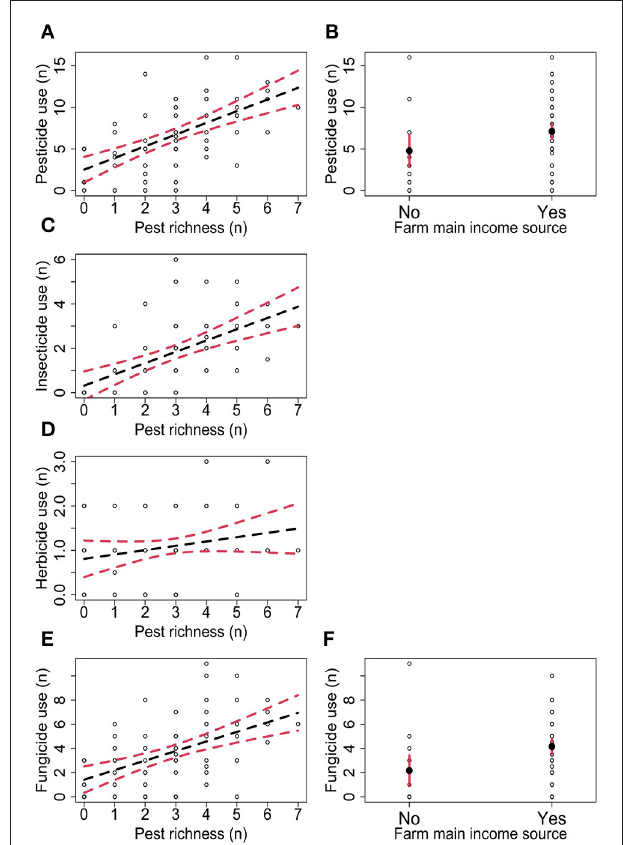
FIGURE 3 | Model averaged predictions plotted with raw survey data for variables mediating the use of (A,B) all pesticides, (C) insecticides, (D) herbicides, and (E,F) fungicides. (A) Pesticide use was positively related to pest richness, particularly for (C) insecticides and (E) fungicides. (D) A weak positive relationship was observed between herbicide use and pest richness. Farming as the main source of income was positively related to (B) overall pesticide use, and (F) the use of fungicides.